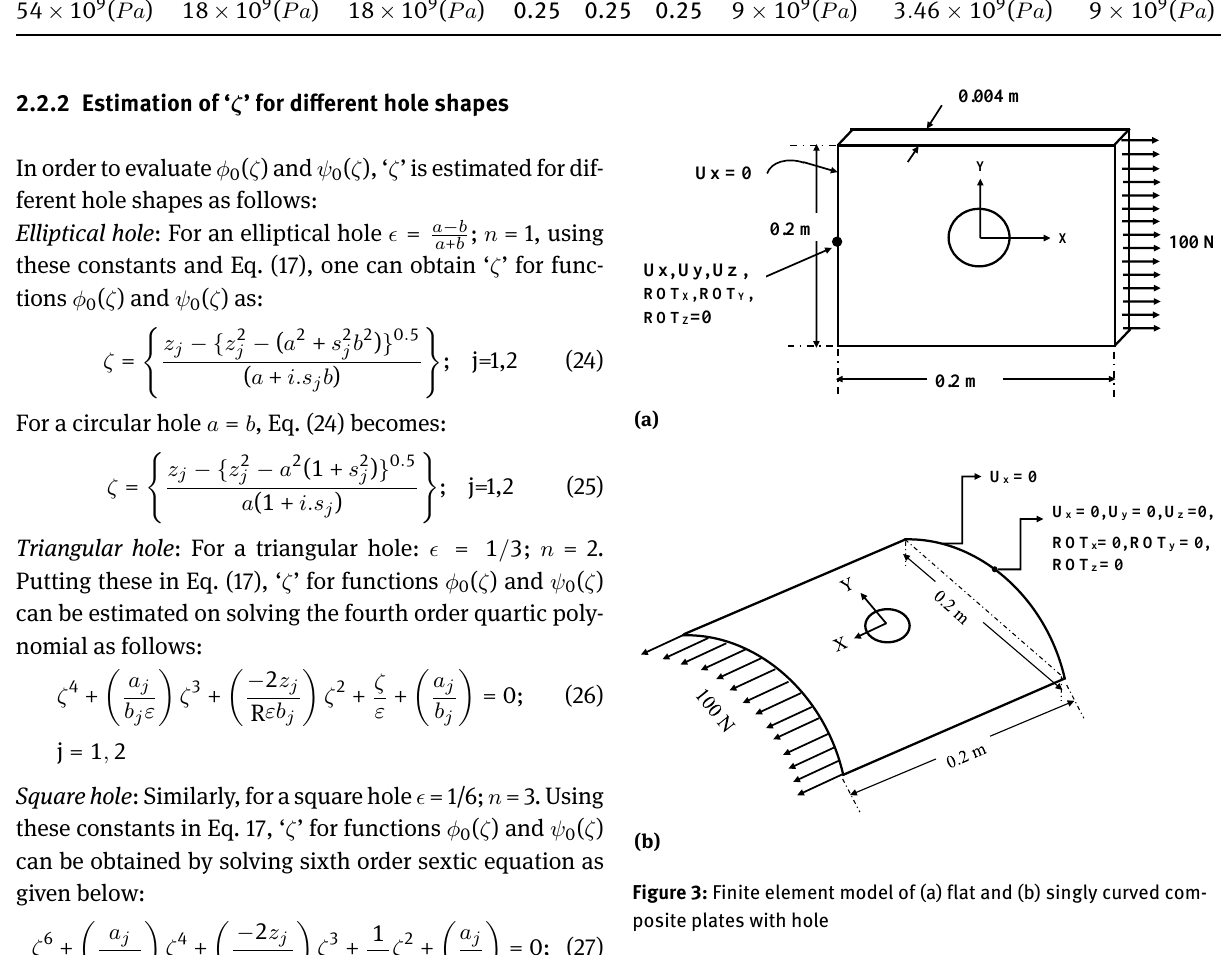
Table 1: Material properties considered for modelling 𝐸 𝑥